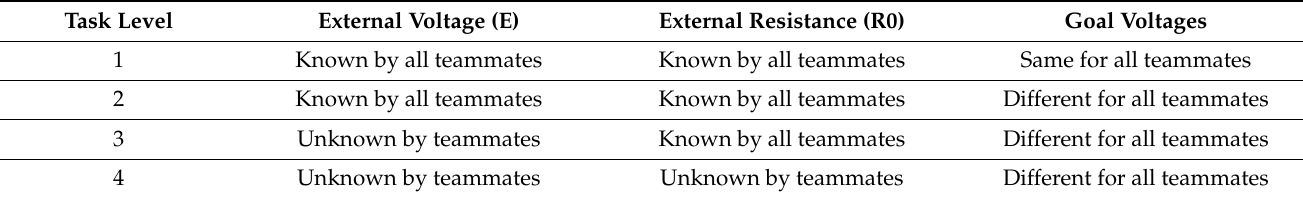
Table 1. Overview of Three-Resistor Activity levels.